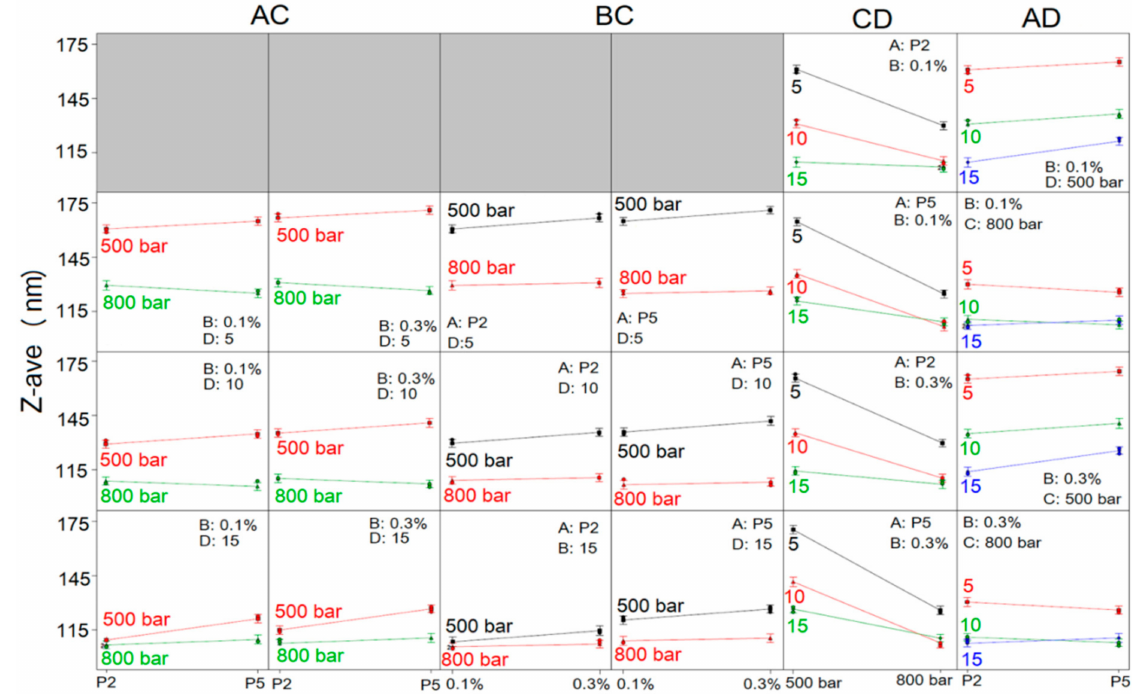
Figure 2. Interaction graphs for the mean droplet size (Z-Ave) of designed placebo nanoemulsions; P2-PEG2000-DSPE; P5-PEG5000-DPPE. AC—PEG-PL type/HPH pressure interaction; BC—PEG-PL concentration/HPH pressure interaction; CD—HPH pressure/number of HPH cycles interaction; AD—PEG-PL type/number of HPH cycles interaction.